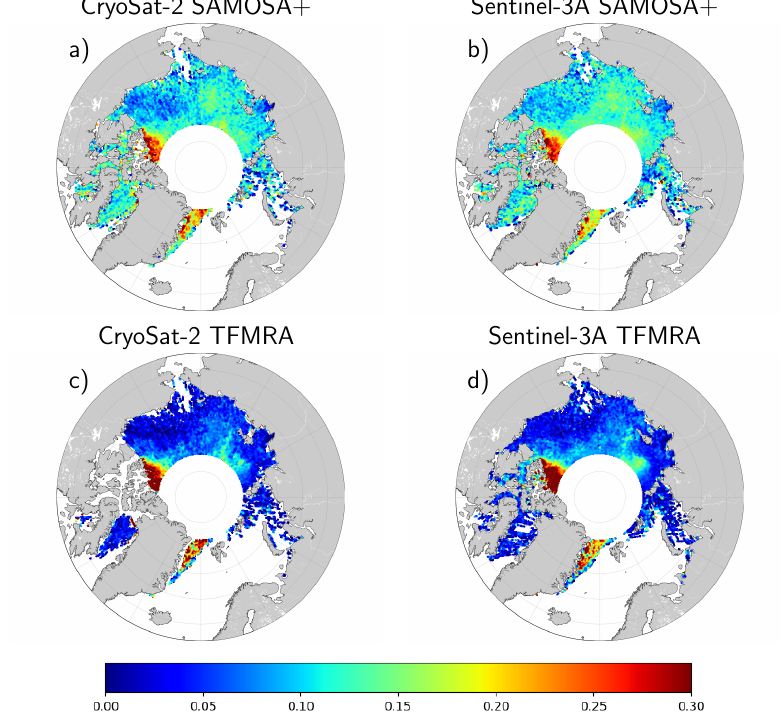
Figure 42. Comparison of sea ice freeboard measurements for December 2016. CryoSat-2 ( a , c ) and Sentienl-3A ( b , d ), and with SAMOSA+ retracker ( a , b ) and TFMRA50 ( c , d